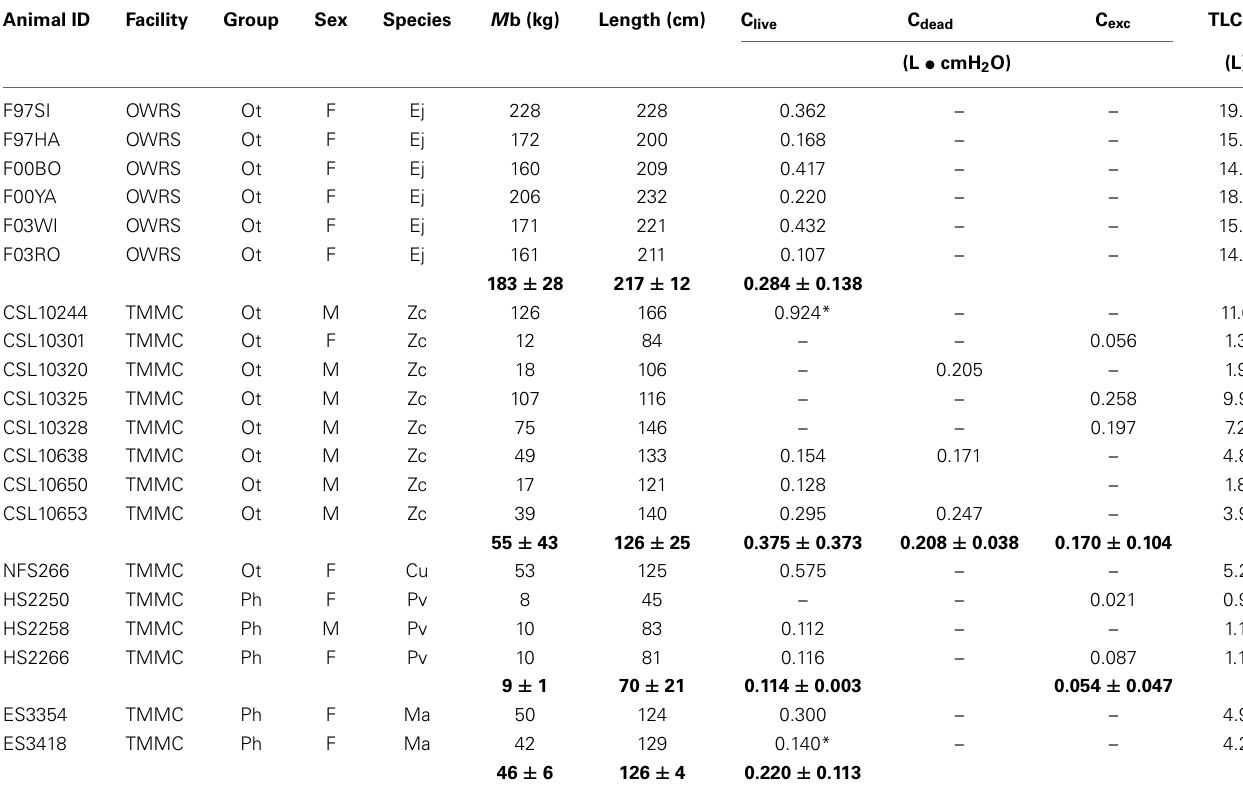
Table 1 | Animal identification number (Animal ID), facility (The Marine Mammal Center, TMMC; Open Water Research Station, OWRS), group (Ph = phocid, Ot = otariid), sex (F-female, M-male), species (Pv = Phoca vitulina , Ma = Mirounga angustirostris ; Cu = Callorhinus ursinus ; Zc = Zalophus californianus ; Ej = Eumetopias jubatus ), body mass ( M b ), animal length, and compliance (L • cmH 2 O) for live (C live ), intact dead animals (C dead ) and excised lungs (C exc